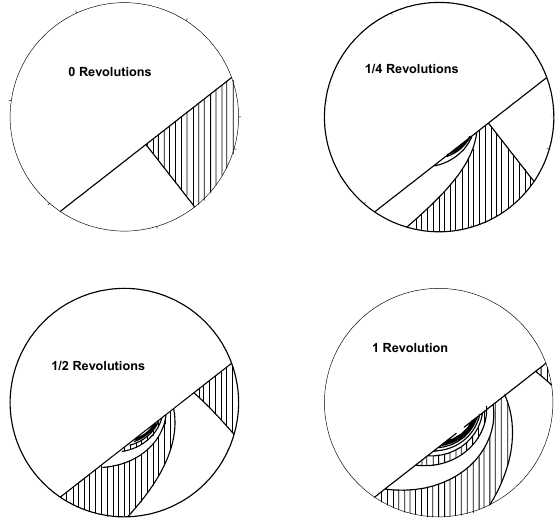
Fig. 3 Schematic representation of transverse mixing in a horizontal rotating cylinder at 30% filling.